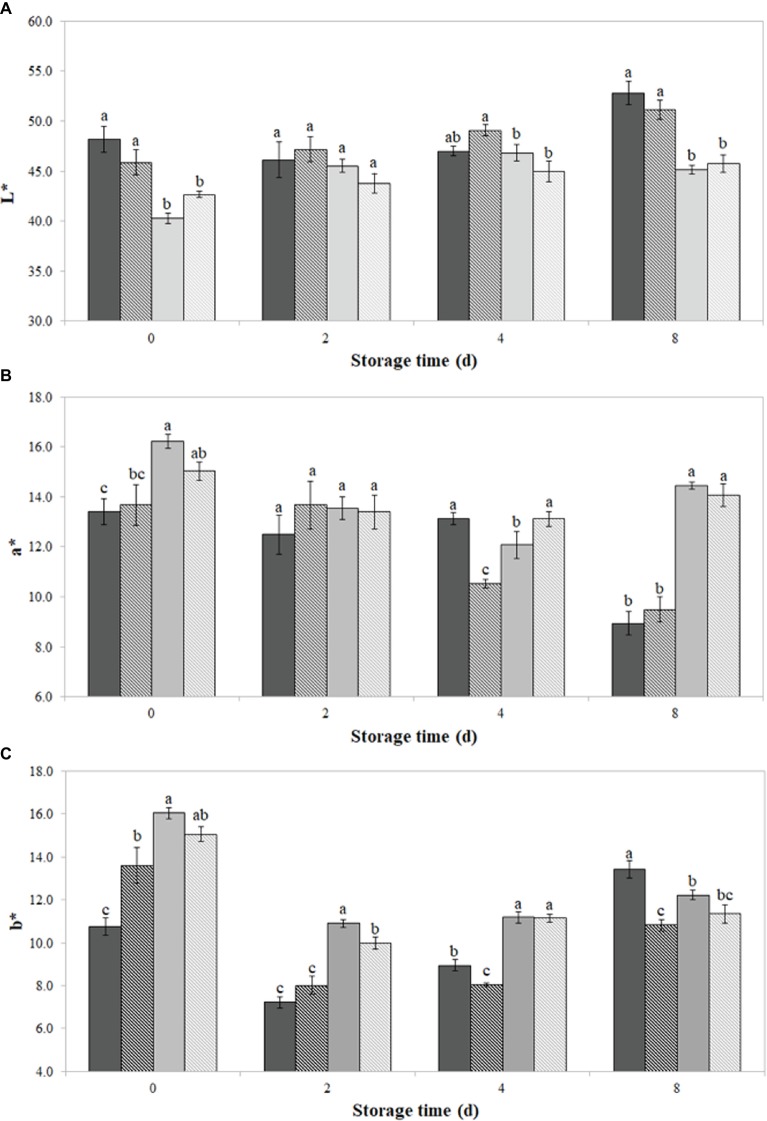
Color values L* (A), a* (B), and b* (C) of burger patties incorporating prickly pear extract (PPE) and encapsulated prickly pear extract (Encaps-PPE). Controls were made incorporating sterile distilled water (SDW) or encapsulated sterile distilled water (Encaps-SDW). Color parameters were measured in burger surface up to 8 days of storage at 4 ± 1°C. Vertical bars indicate the standard deviation of the mean.  SDW  Encapsulated-SDW  PPE  Encapsulated-PPE.